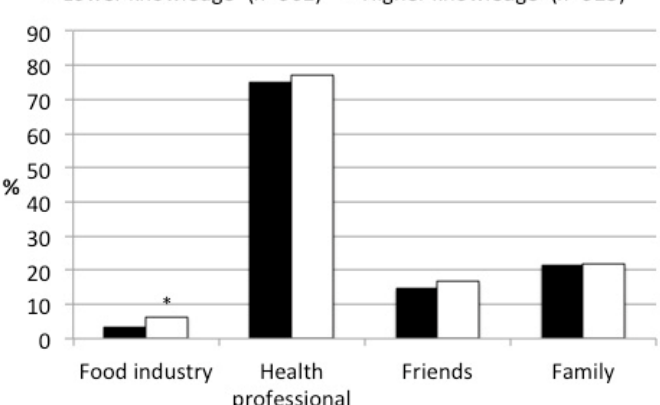
Figure 2. Proportions of the participants in the two protein knowledge level groups who would increase the amount of protein in current diet if told to do so by the information source ( n = 1825). * Significant difference between the proportions of the two knowledge groups based on chi-square test ( p -value < 0.01). The percentages refer to the responses of "yes" as opposed to "no" or "don’t know".